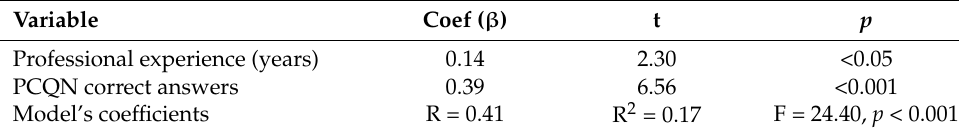
Table 8. Regression model for the outcome “attitudes toward care of